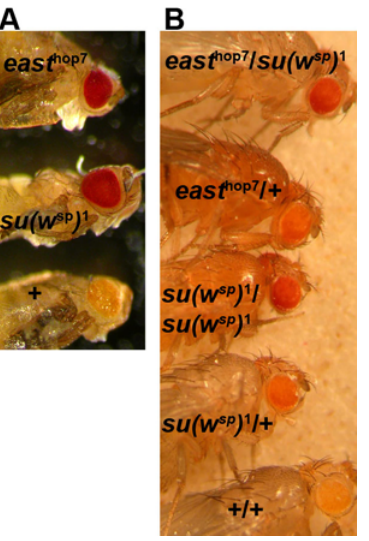
Figure 4. east corresponds to suppressorofwhite-spotted. All flies shown are homozygous for w sp1 . (A) In male pharates dissected out of pupal cases, the mutations east hop7 and su(w sp ) 1 suppress the loss of eye pigmentation resulting from the white mutation w sp1 . (B) The mutations east hop7 and su(w sp ) 1 show complementation. Like su(w sp ) 1 / su(w sp ) 1 , the combination east hop7 / su(w sp ) 1 restores eye pigmentation to almost wildtype levels. Heterozygous flies of each mutation display intermediate eye pigmentation.